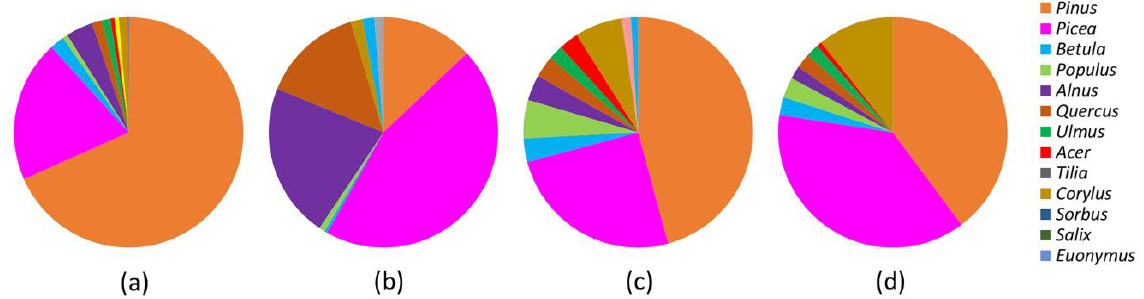
Figure 4. Taxonomic composition of soil charcoal in different local areas (sites): ( a ) Zavorovka- Likhusha, ( b ) Runa-Zaborovka, ( c ) Voroshilovo, ( d ) Krasnyi Bor.